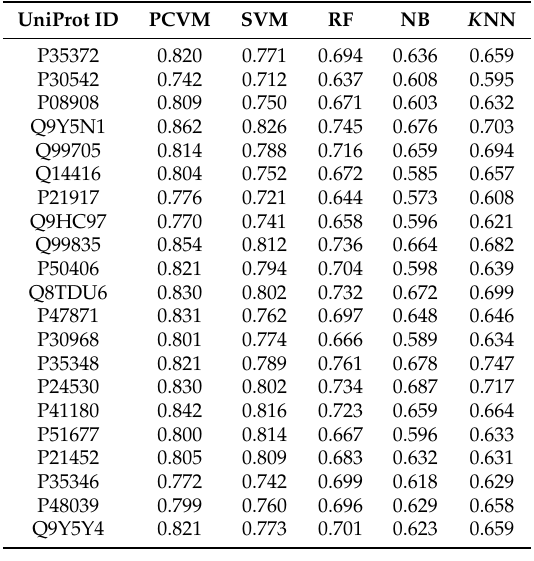
Table 2. Performance comparison of target prediction methods in terms of Accuracy. Scores for the external test set.